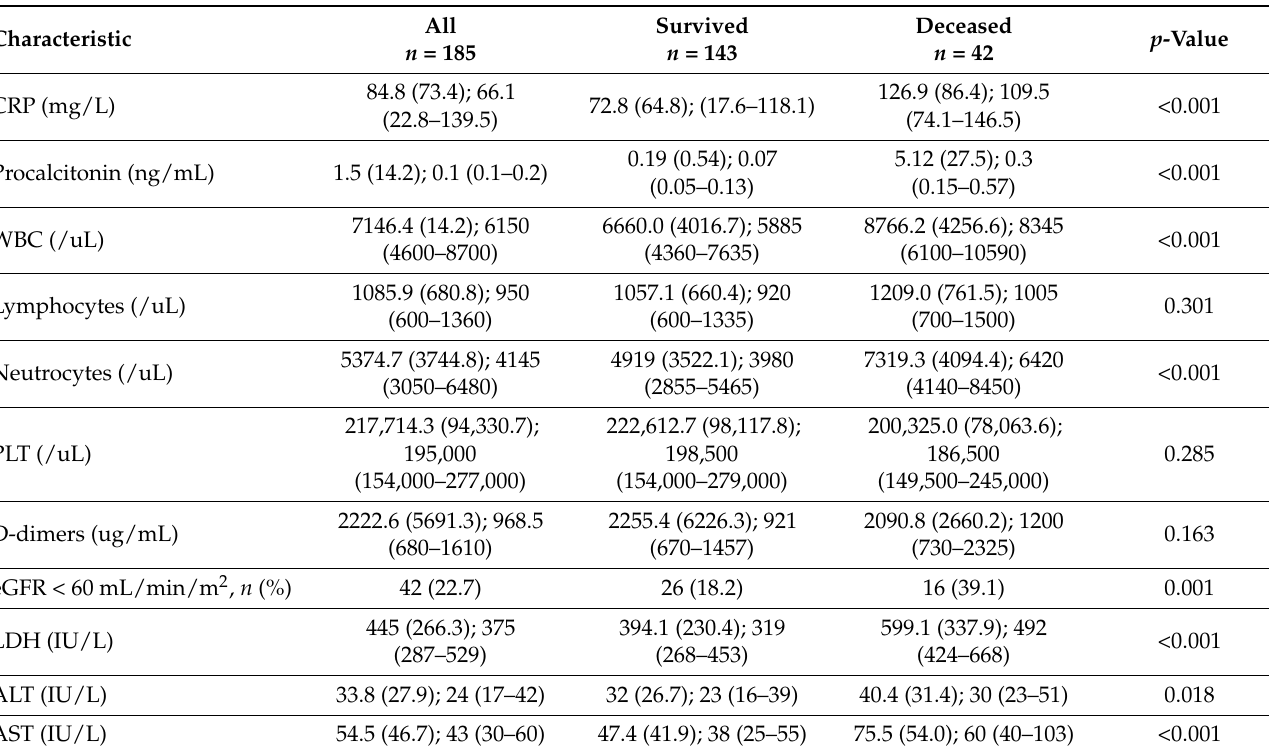
Table 2. Laboratory characteristics in patients with SARD, mean (SD); median